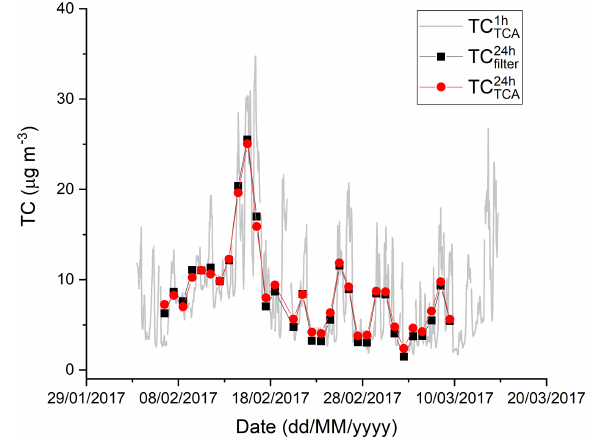
Figure 5. Time series comparison of off-line results for TC derived from offline filter analyses to 1 and 24h averaged TC data from the on-line TCA08 measurements.